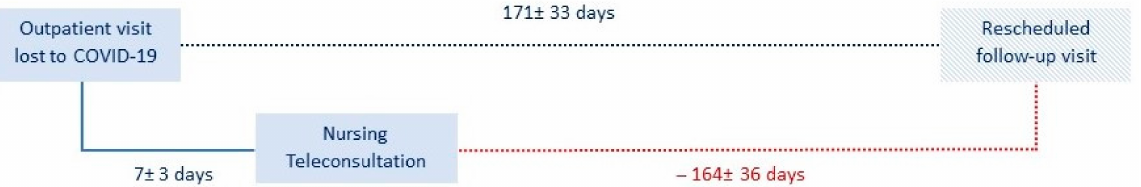
Figure 3. Time between the outpatient visit lost due to the COVID-19 lockdown, nursing teleconsultation and rescheduled in-person follow-up visit.